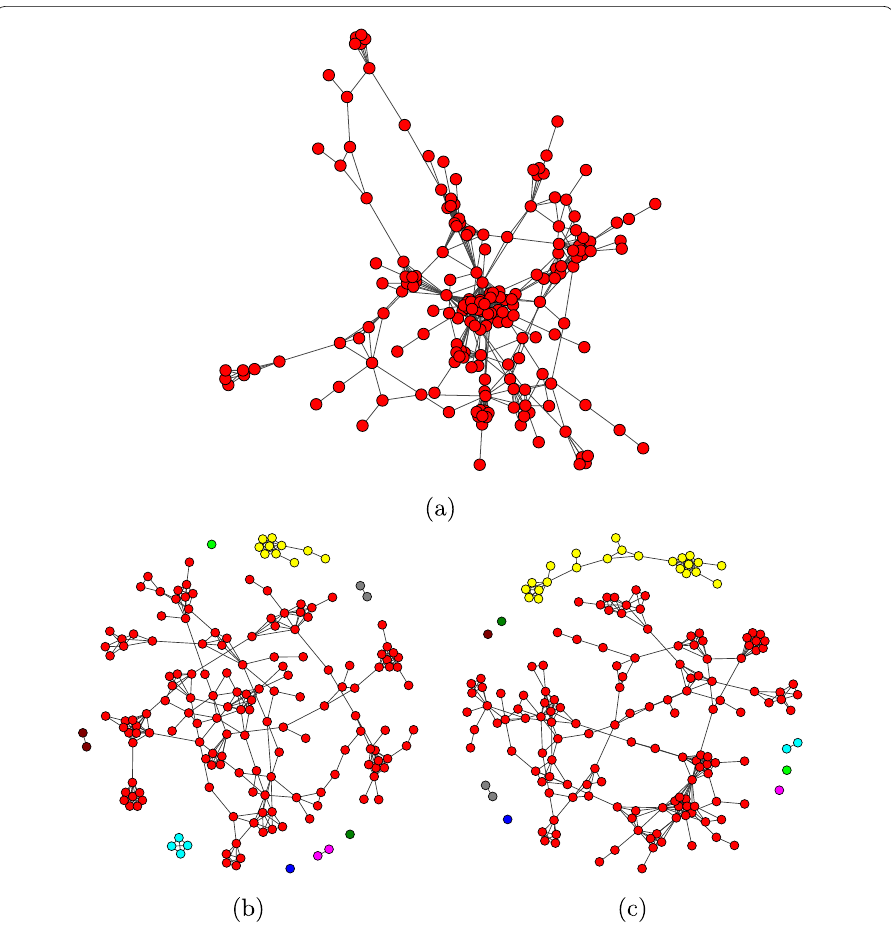
Figure 6 ( a ) Complete network before dismantling. ( b ) Network after removing a fraction p ( syndicate ) c of nodes using the dismantling order based on degree. The largest connected component has lost 21 nodes (11%) ( c ) Network after removing a fraction p ( syndicate ) c of nodes using the dismantling order based on syndicates. The largest connected components has lost 30 nodes